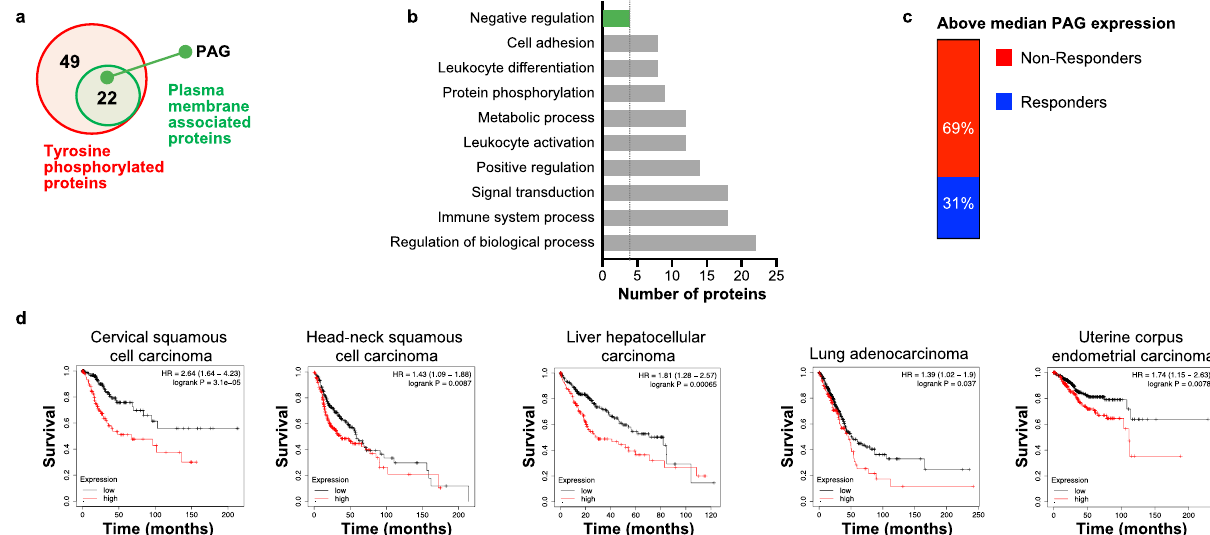
Fig. 1 PAG is associated with negative regulation of biological processes. a Phosphoproteins were enriched for in the lysates of anti-CD3 or anti-CD3 + PDL2 stimulated Jurkat cells then identi fi ed by mass-spec 30 . 49 proteins were found to be enriched in the anti-CD3 + PDL2 condition relative to unstimulated or anti-CD3. 22 of these proteins were plasma membrane associated, including PAG. b Analysis of the biological processes associated